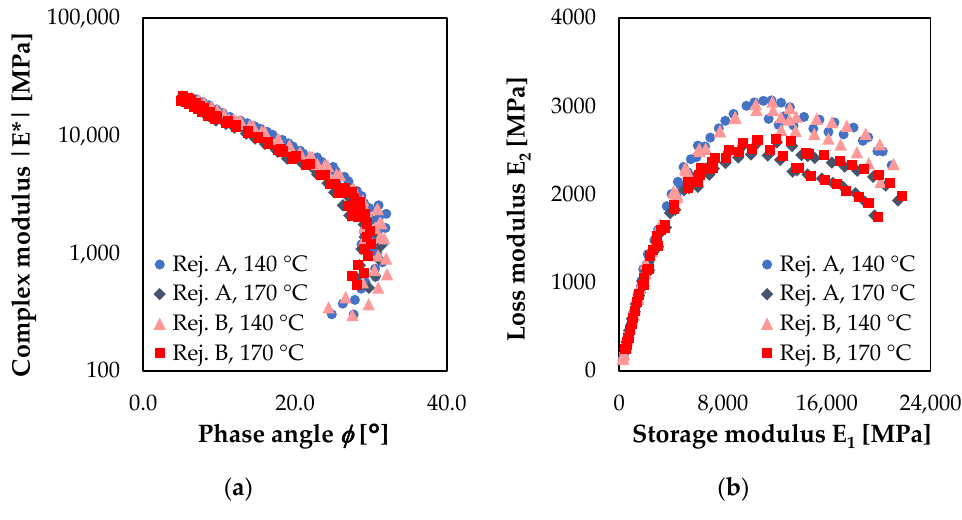
Figure 8. Rheological data: ( a ) Black space; ( b ) Cole – Cole plot.